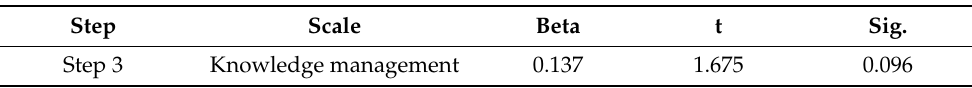
Table 7. Variables outside the regression equation to predict export development by applying business intelligence dimensions.